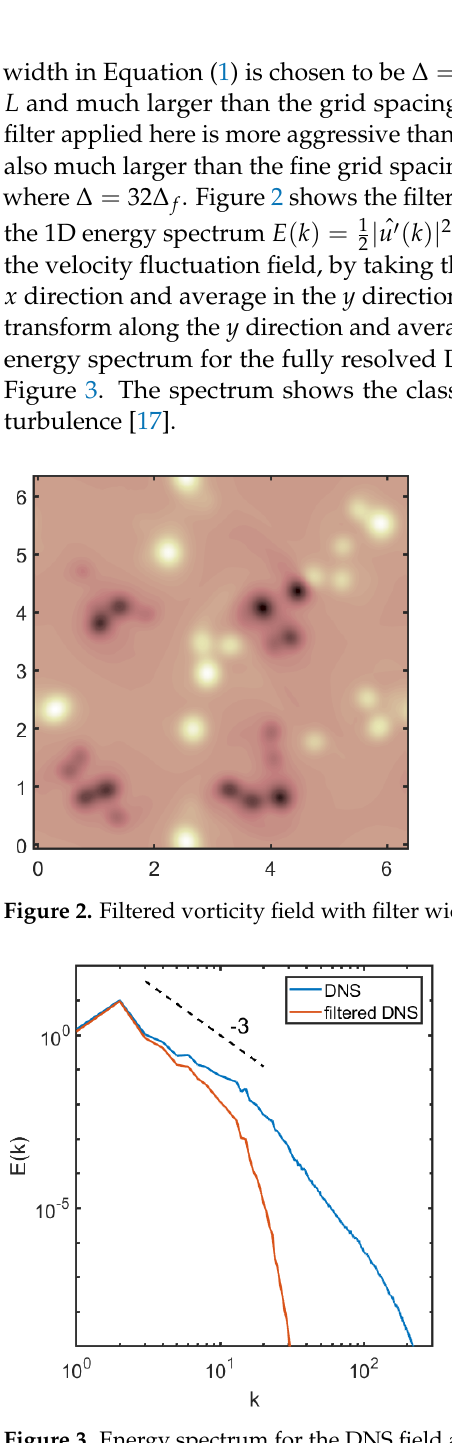
Figure 3. Energy spectrum for the DNS field and the filtered DNS field at t ∗ =